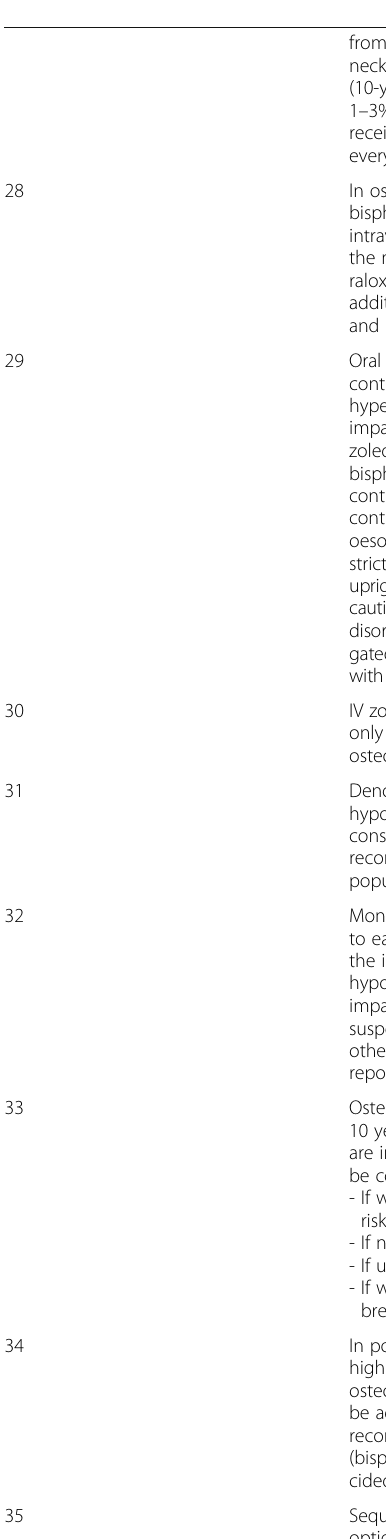
Table 2 Breakdown of statements of recommendations, its individual rank, and level of agreement (Continued)